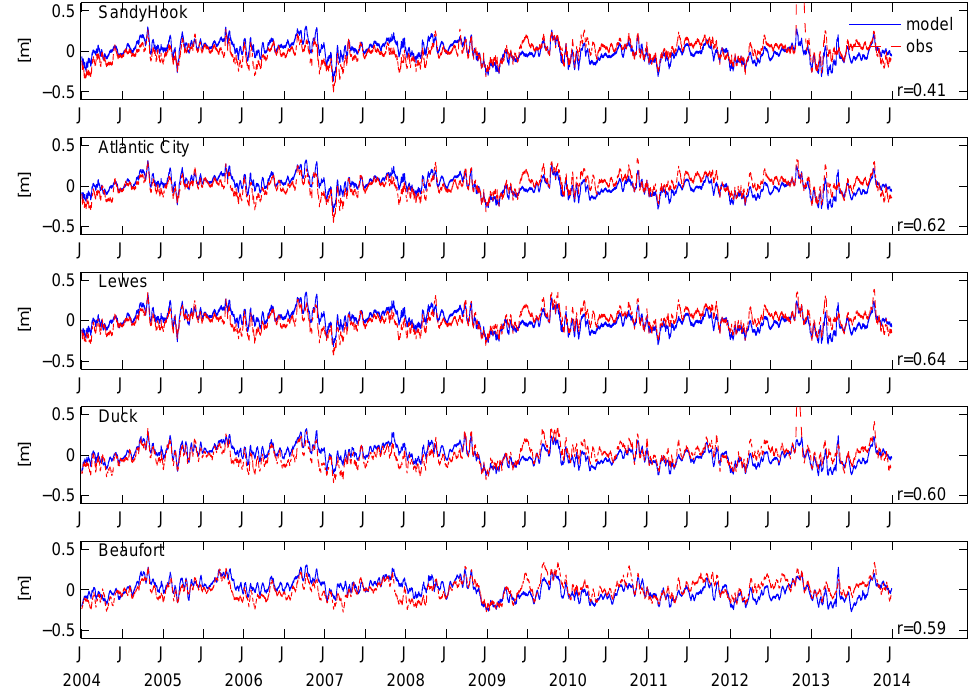
Figure 3. Comparisons of modeled and observed coastal sea levels. Time series are all 10-day low-pass filtered. The correlation coefficient ( r , above with 95% confidence level) is also included for each